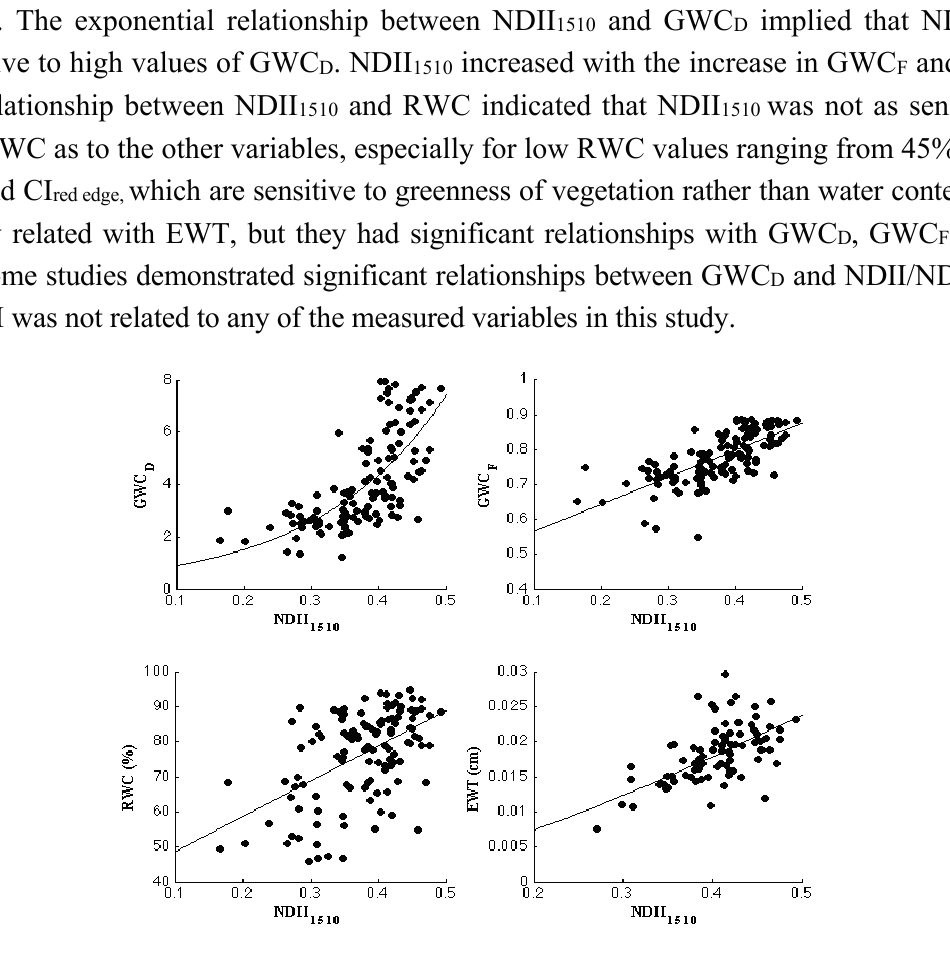
Figure 4. Relationships between NDII 1510 and GWC D , GWC F , RWC, EWT at leaf level of winter